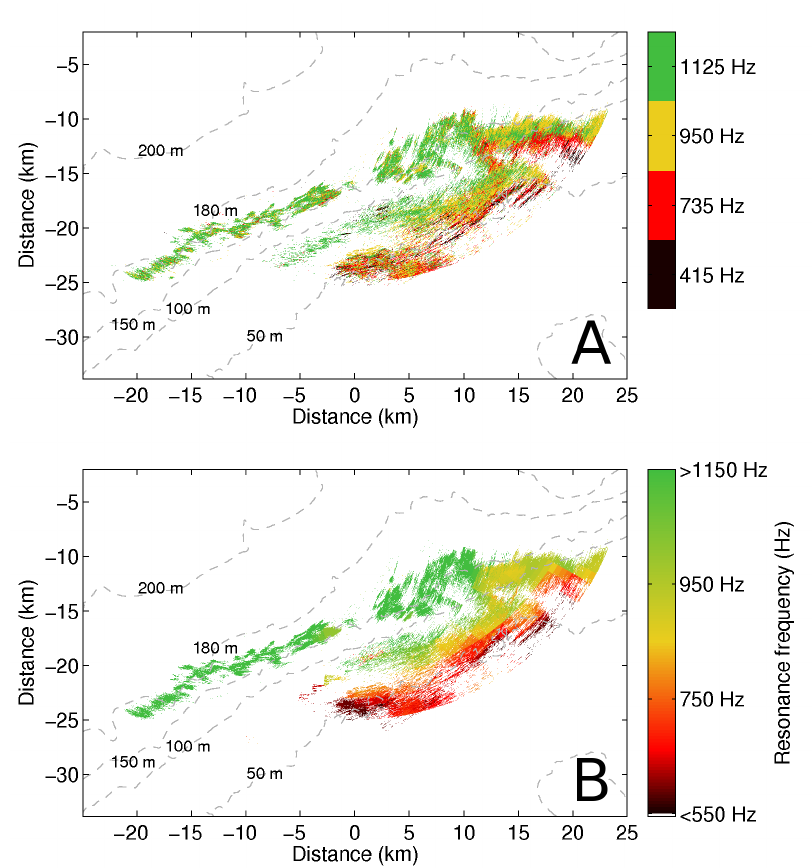
Figure 4. ( A ) spatial distribution of frequency at which the strongest acoustic scattering occurred within vast herring groups imaged from 17:25:00 to 21:37:30 EDT on 29 September 2006. Gradual decrease in the strongest scattering frequency with decreasing seafloor depths indicates a consistent shift in the resonance frequency of herring scattering during the spawning migration towards the spawning grounds on Georges Bank; ( B ) the spatial distribution of the resonance peak frequency within vast herring groups imaged from 17:25:00 to 21:37:30 EDT on 29 September 2006. We show the variation in the frequency response of herring scattering as a function of seafloor depth in Figure 5, where the resonance peak frequency decreases with decreasing seafloor depth. The resonance peak frequency of herring is found to be roughly at 1500 Hz outside the frequency band of the current OAWRS measurements when herring began their shoal formation process in deeper waters. As the herring groups fully develop and migrate towards the shallower spawning grounds (Figures 4B and 5), the resonance peak is fully captured and studied because it moves into the frequency range of OAWRS measurements. Our findings are consistent with the results of a previous study [5], where the resonant scattering from herring was investigated during the initial shoal formation process in the basin area with the seafloor depth of 180–200 m on the northern flank of Georges Bank. In this study, a characteristic 20 dB/octave roll-off of the damped-harmonic-oscillator sub-resonance behavior as the frequency decreased was confirmed by the measured frequency response. The resonance peak frequency was consistently inferred at roughly 1500 Hz outside the OAWRS measurement frequency range for the herring groups in this initial stage of the herring spawning